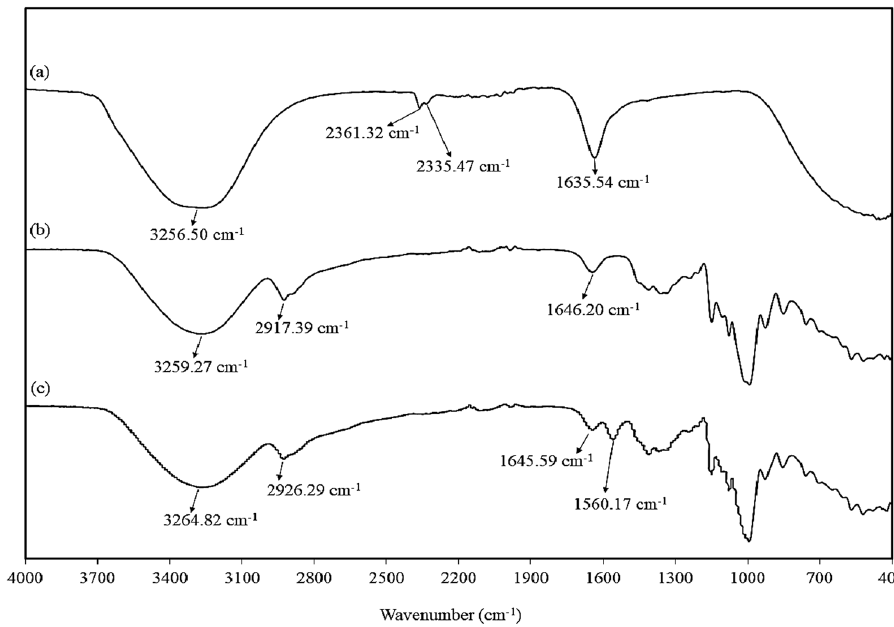
Figure 1: FTIR spectra of ( a ) CNP, ( b ) neat starch fi lms, and ( c ) starch/CNP fi